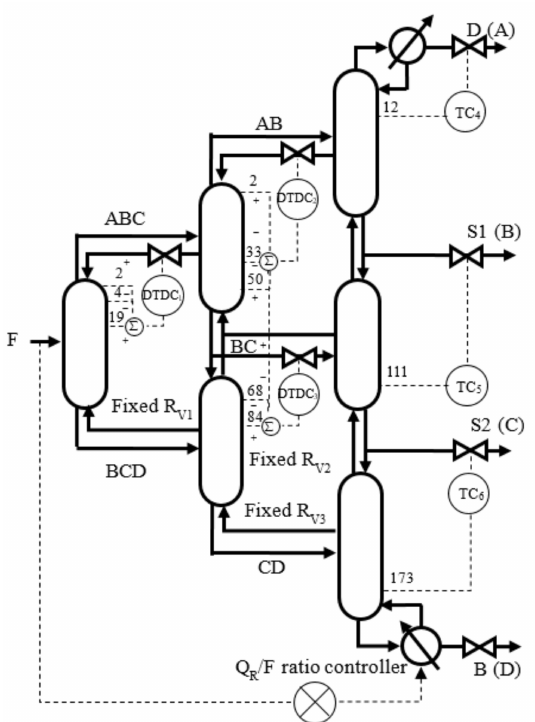
Figure 9. Simplified double temperature di ff erence control scheme